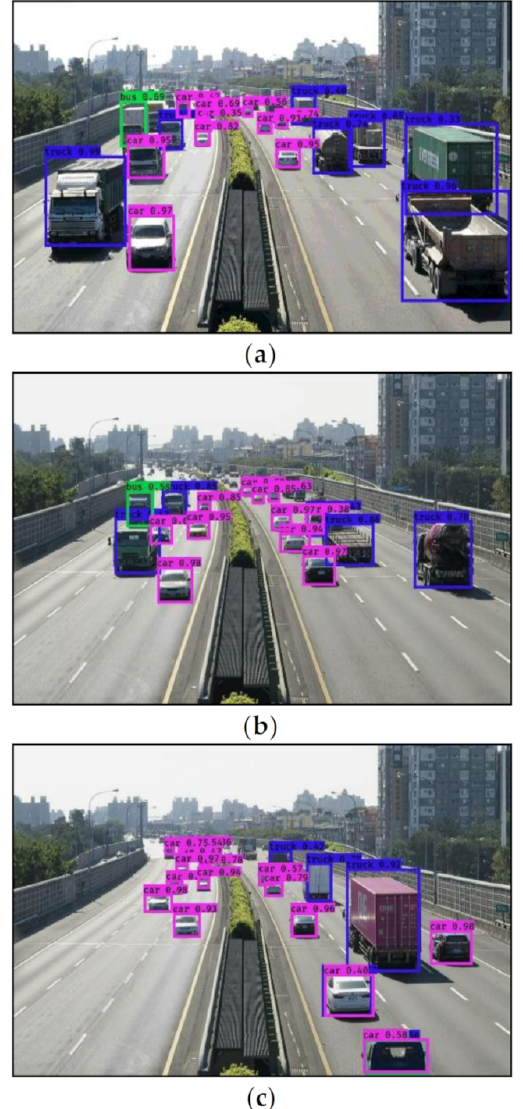
Figure 7. Object detection results on the video taken on National Freeway No.1 ( a – c ). The identified vehicles were wrapped with their respective bounding boxes. The colors of the bounding boxes represent the categories of the vehicles: cars (magenta), trucks (blue), and buses